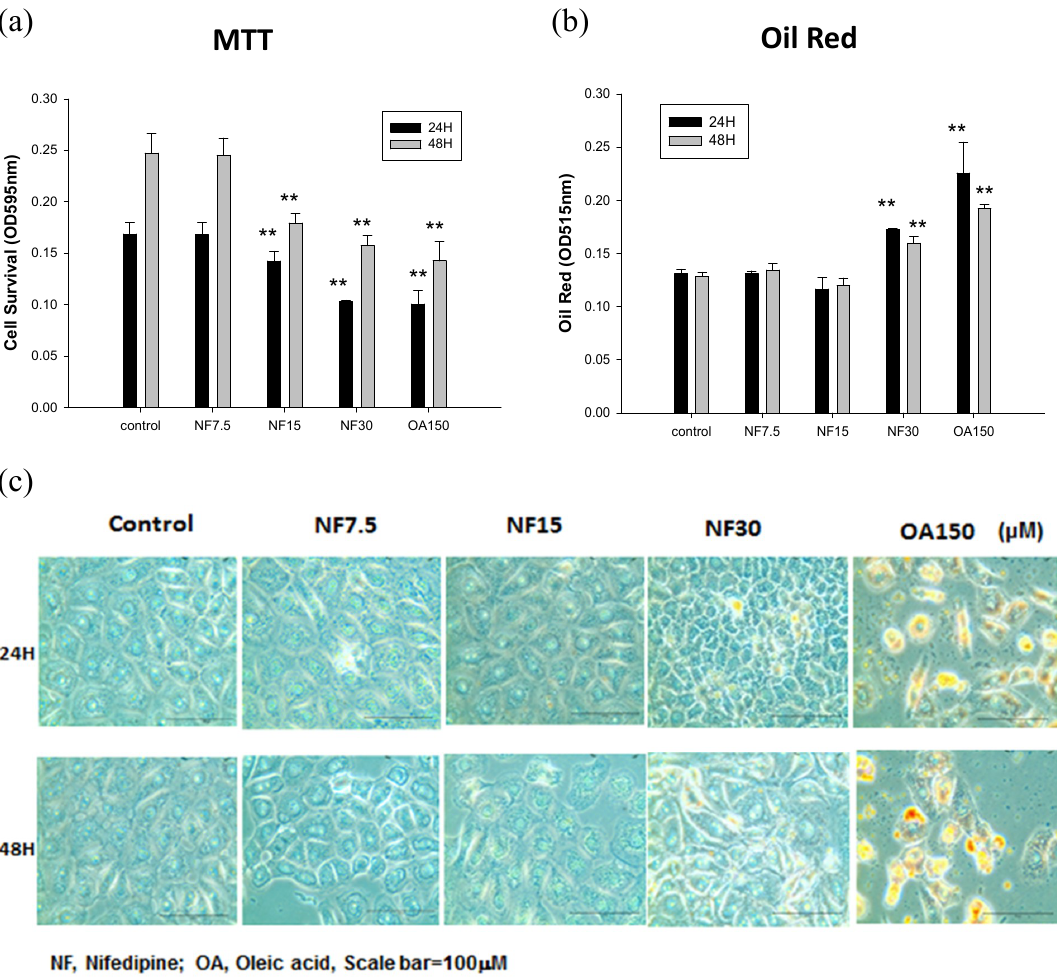
Figure 1. The effect of nifedipine on the cell viability, and intracellular lipid accumulation in NRK52E tubular cells. ( a ) The nifedipine treated cells (15, 30 µ M) showed decreased viability compared to control ( p < 0.01) in 24 or 48 h of MTT assays. ( n = 3) ( b ) The nifedipine treated cells (30 µ M) and oleic acid (150 µ M) showed an increasing effect on quantification of Oil Red O staining comparing to control ( p < 0.01) in 24 or 48 h. ( n = 3) ( c ) The microscopic Oil Red O staining of NRK52E (magnification, 400 × ) treated with nifedipine and oleic acid are also shown: ( top ) 24 h; and ( bottom ) 48 h. p -values ≤ 0.05 (marked as **) were considered statistically significant. The bar size in ( c ) is 100 µ